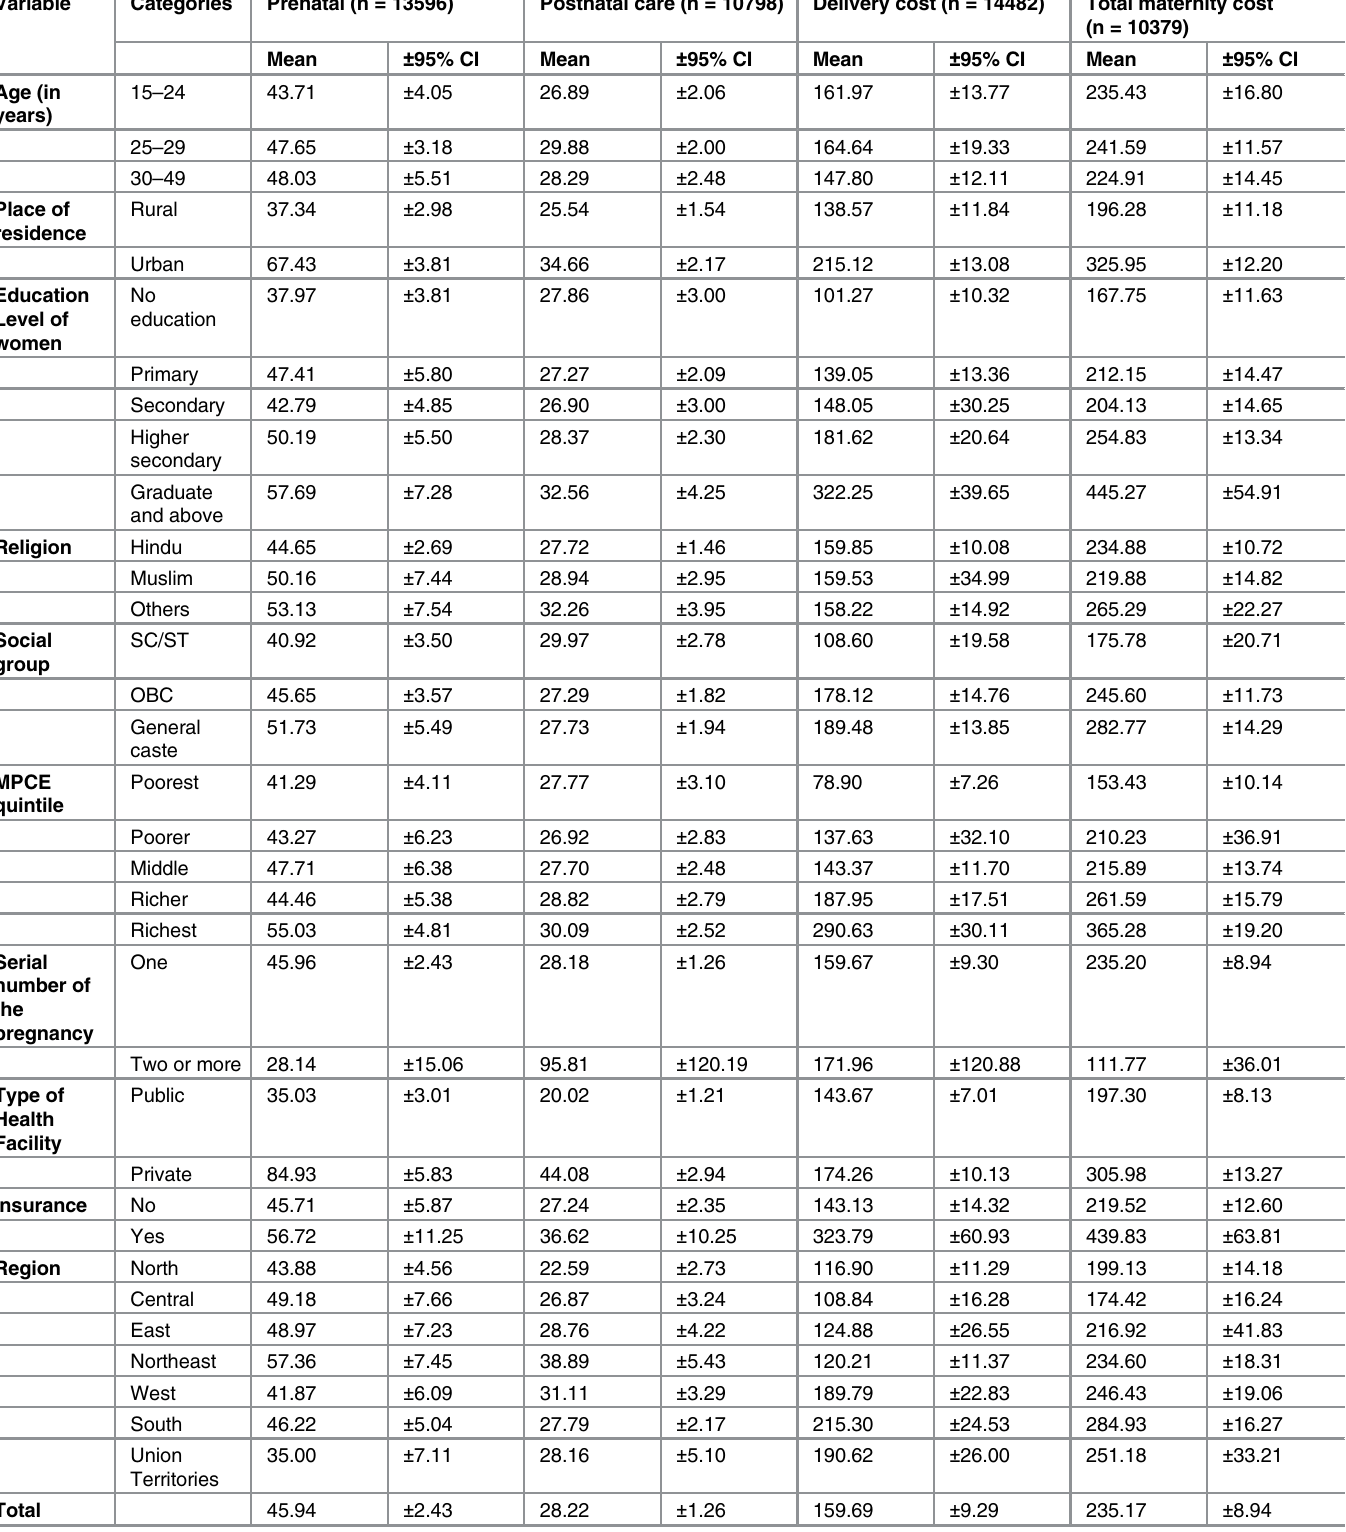
Table 2. Mean spending (US$) on maternity care